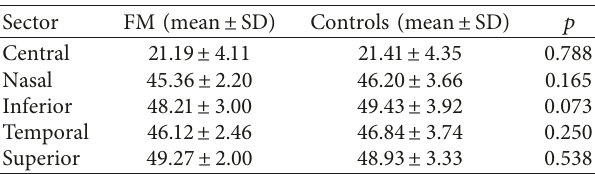
Table 5: Vascular plexus density in the macular area measured with the Triton optical coherence tomography angiography in patients with fibromyalgia and healthy